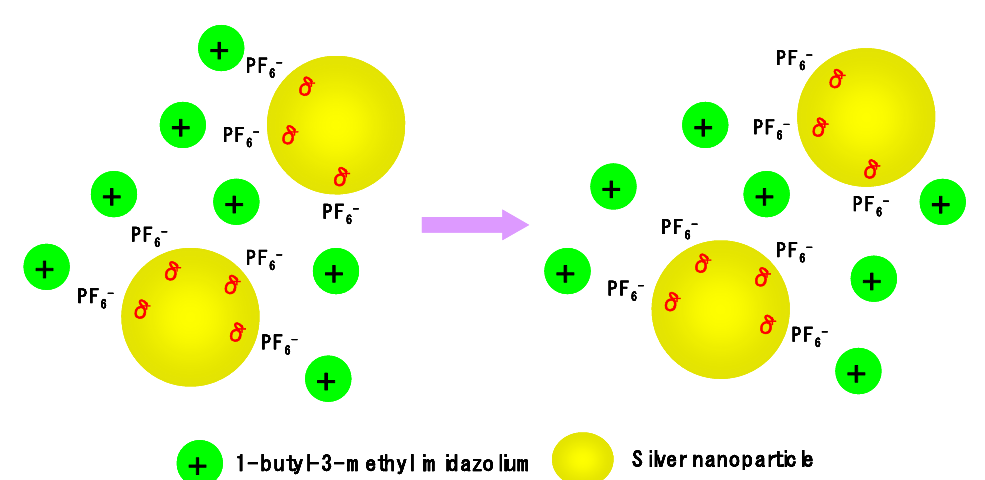
Figure 5. Binding energy of Ag in 1/0.7 BMIM + PF 6 − /Ag composites after preparation and after 1